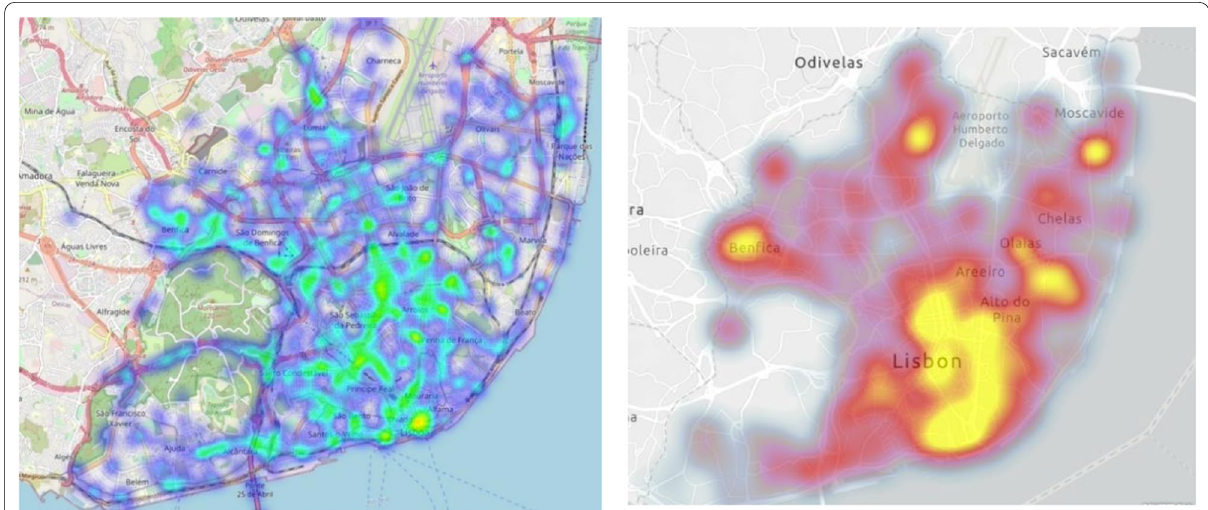
Fig. 2 Distribution of incidents in the city of Lisbon from [19]. On the right is the occurrence of incidents and on the left, their impact on pathways, i.e., the number of roads affected